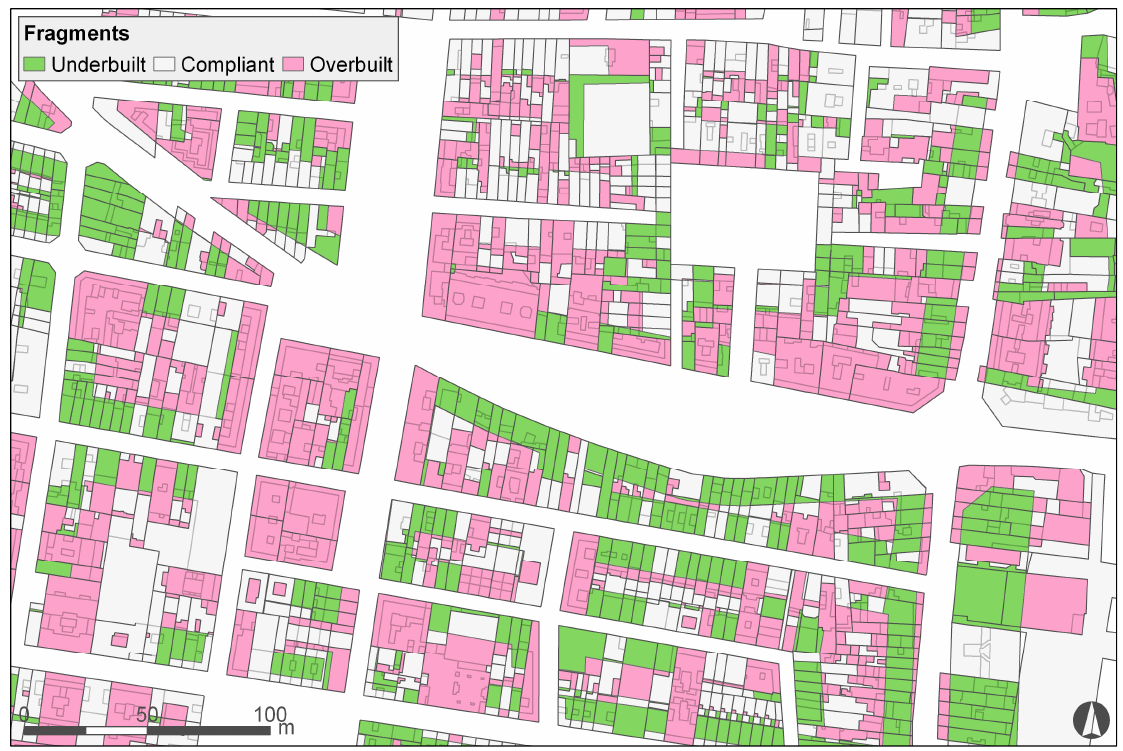
Figure 13. Partial map of fragments according to their legal